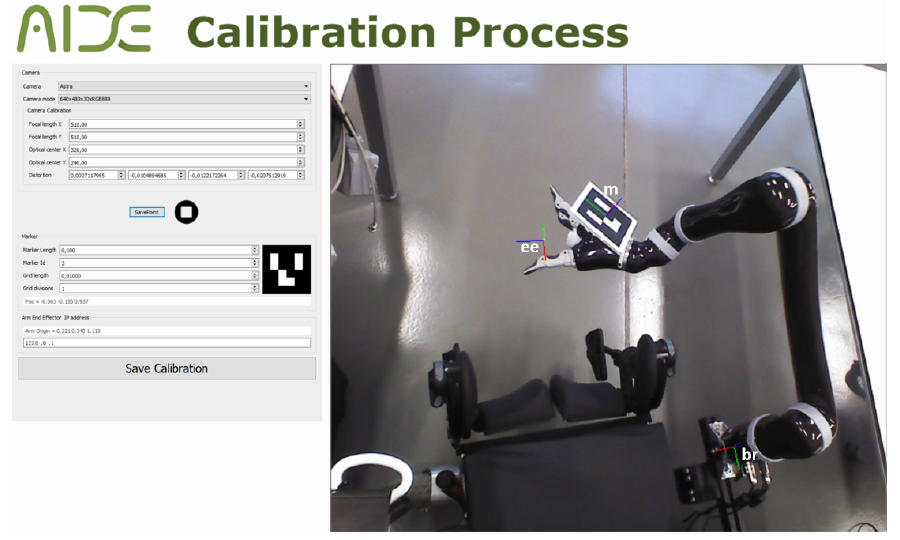
Figure 3. Calibration